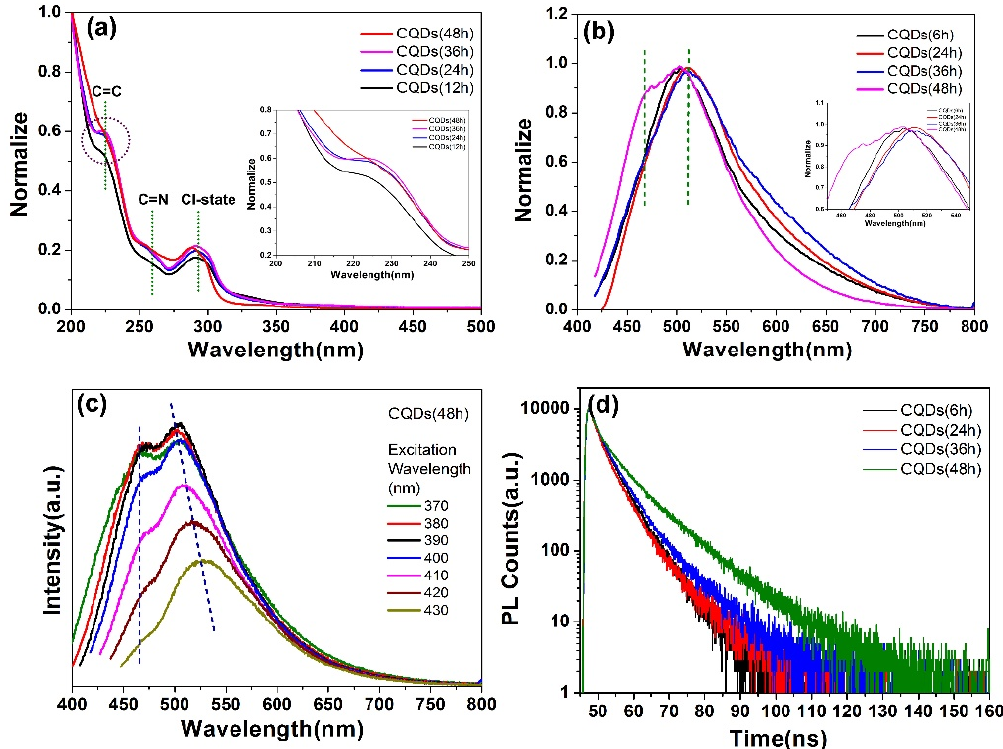
Figure 13. ( a ) UV-Vis absorption spectra of CQDs (12 h), CQDs (24 h), CQDs (36 h) and CQDs (48 h) in aqueous solutions (The inset is an enlarged view of absorbed by C=C); ( b ) PL spectra of CQDs (6 h), CQDs (24 h), CQDs (36 h) and CQDs (48 h) in aqueous solutions (The inset is an enlarged view of emission area in the range of 450 nm–550 nm); ( c ) PL spectra of CQDs (48 h) excited at wavelength of 370–430 nm, with increments of 10 nm; ( d ) PL decay curves of CQDs under excitation wavelength of 400 nm.